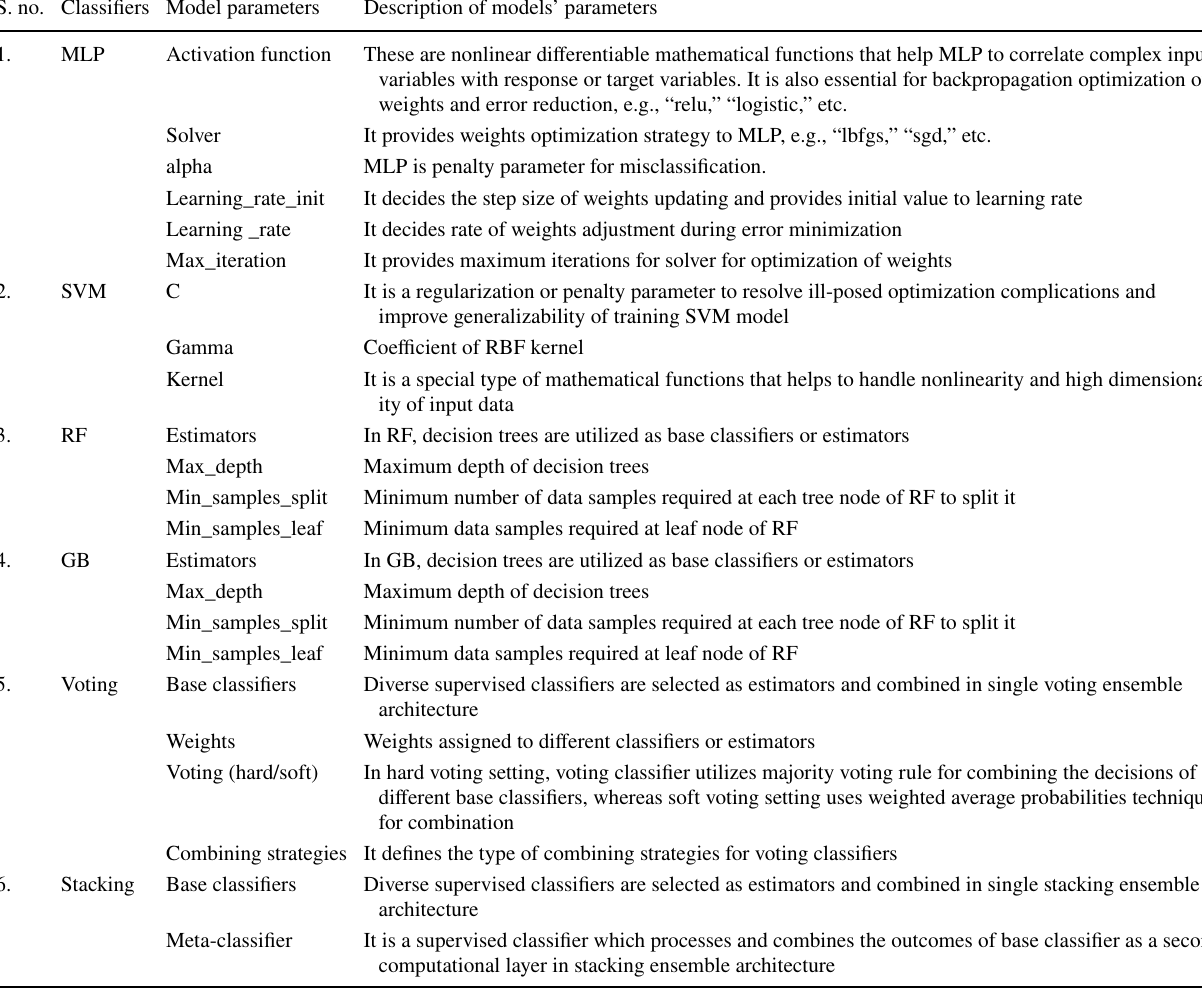
Table 8 A brief description of various important models’ parameters utilized in this study for HEMs